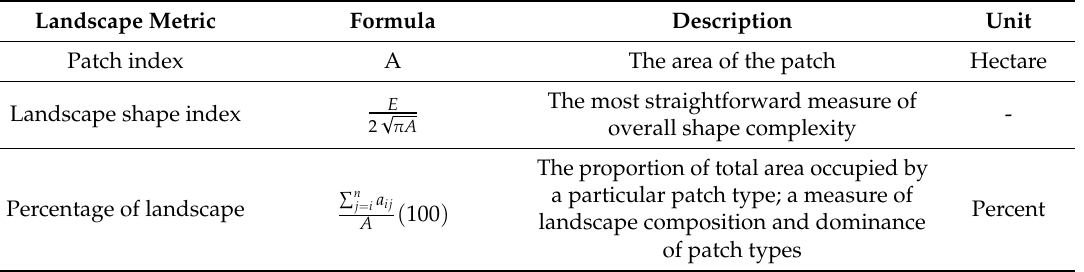
Table 2. Landscape metrics used to describe urban forest